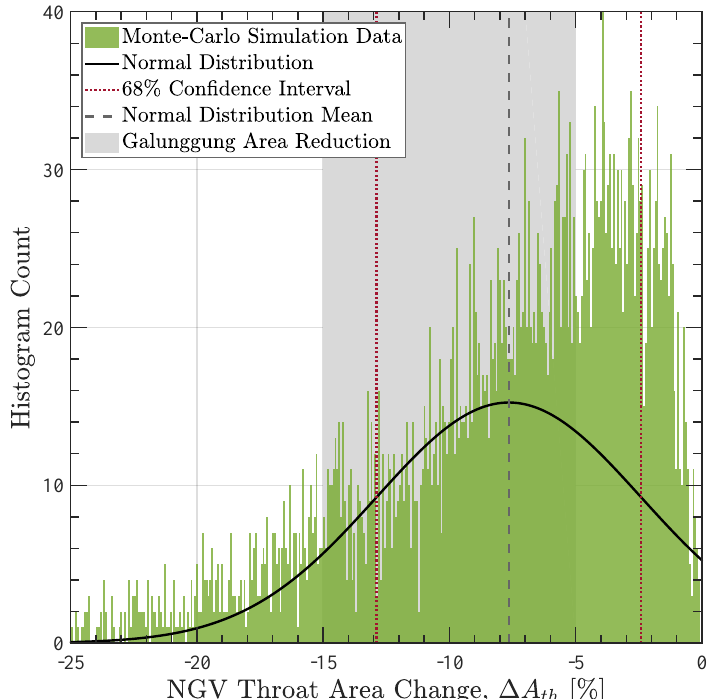
Figure 8. The predicted NGV throat area reduction for the Soputan encounter during which engines did not surge, indicating how this was comparable to that observed for the Galunggung event in which all four engines experienced